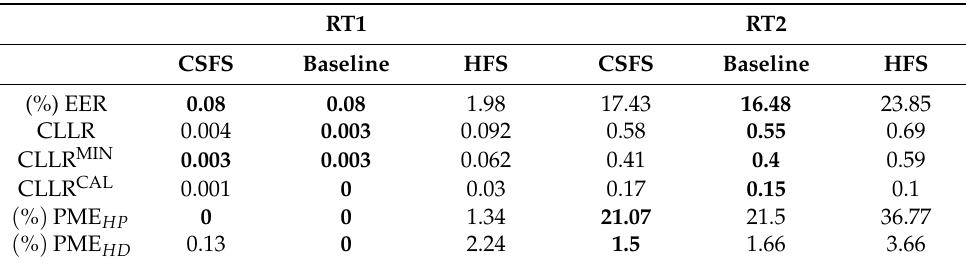
Figure 9. ECE plots: non-stabilized videos vs. RT1 (first row) and RT2 (second row). Table 3. Summary of the results for accuracy, discriminating power and calibration for the non- stabilized videos. The best performance is highlighted in